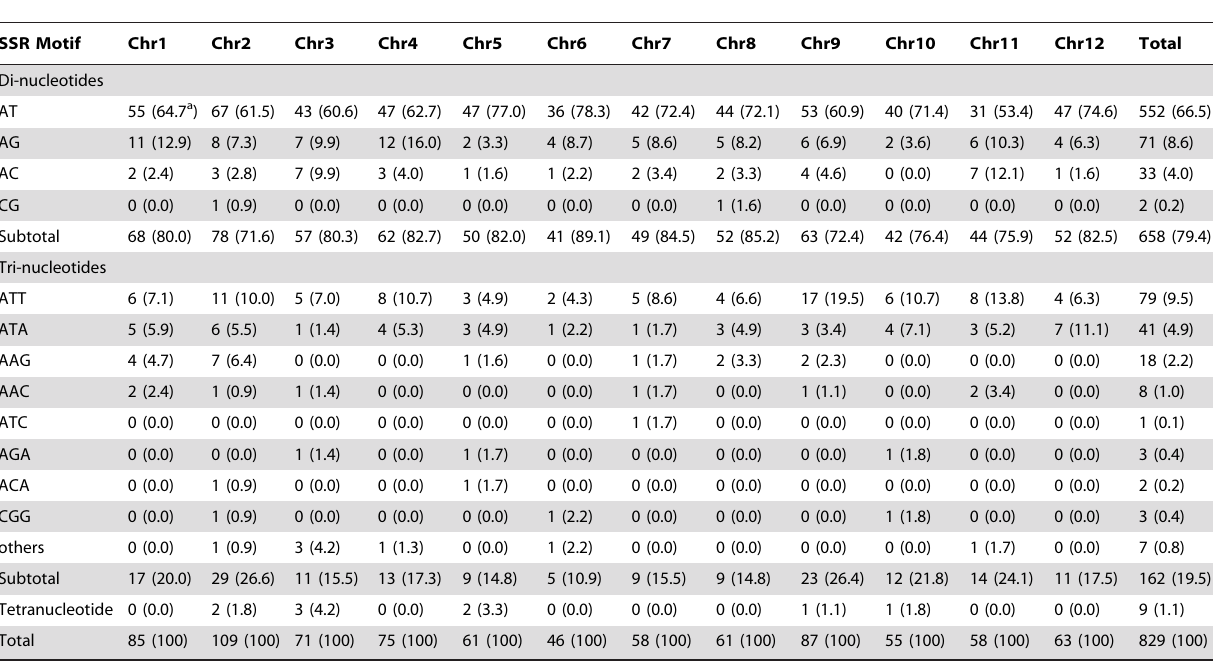
Table 1. Microsatellite repeat motifs of the 829 SSR